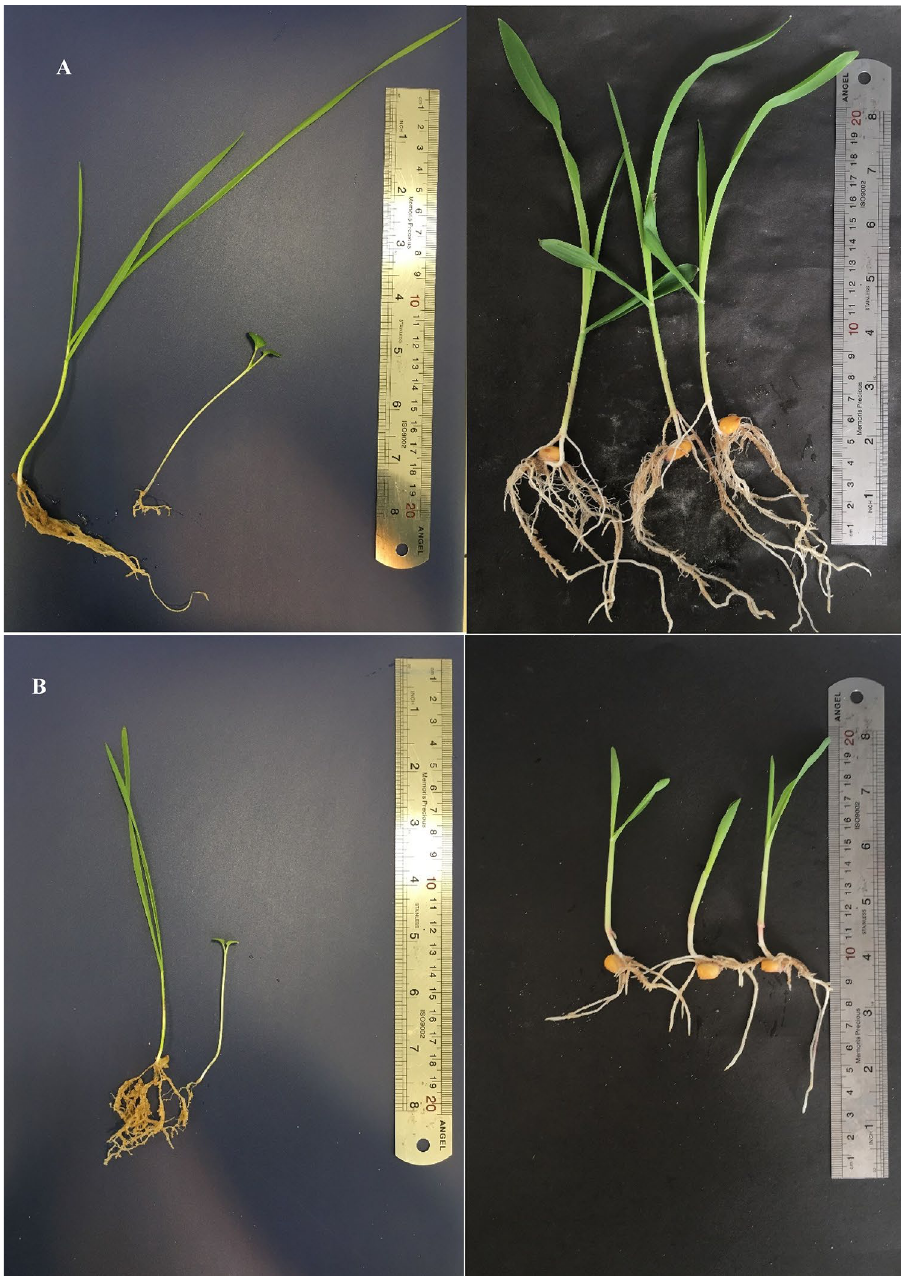
Figure 3. Influence of bacterial isolates on the overall growth of wheat, canola, and maize ( A ) in comparison to uninoculated control condition ( B